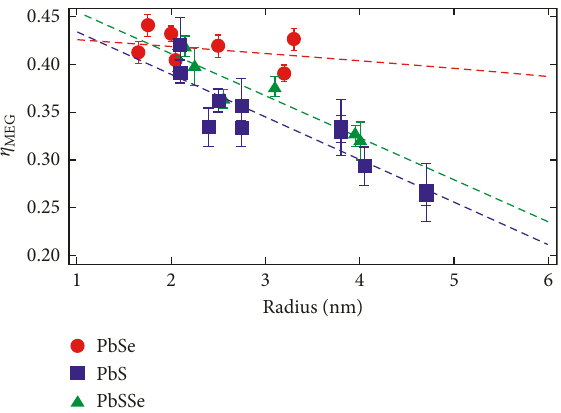
Figure 6: An example of MEG efficiency data plotted against the radius of PbS, PbSe, and PbS x Se 1 − x from [44].